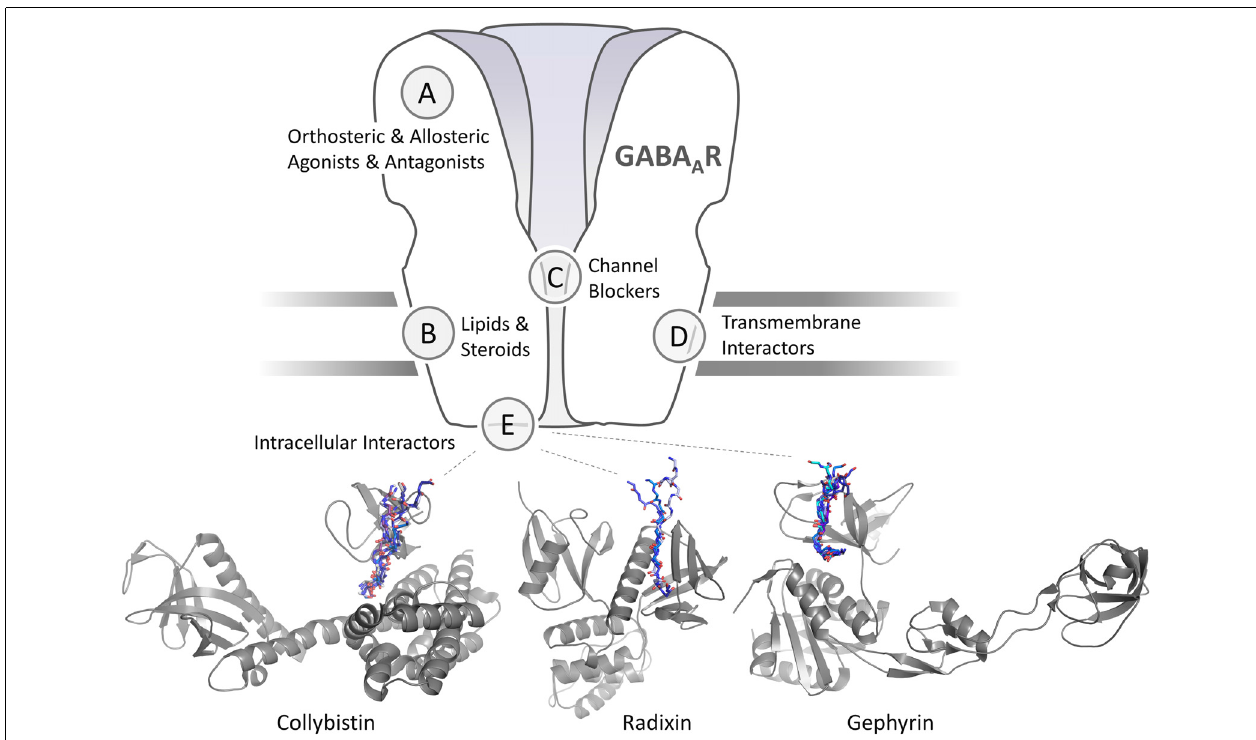
FIGURE 1 | Schematic representation of a γ -aminobutyric acid type A receptors (GABA A Rs) and sites for pharmaceutical intervention. Orthosteric and allosteric agonists and antagonist are classical activity modulators that bind directly to the extracellular domain (ECD) or, in case of lipids and neurosteroids to the transmembrane domain (TMD) of GABA A Rs. Each of the sites could occur in five subunits or at five interfaces, or only in distinct subunits and specific interfaces. Channel blockers bind within the ion pore formed by the GABA A R pentamer. Intracellular interactors such as Collybistin (CB; Hines et al., 2018) and gephyrin (Maric et al., 2014) interact with distinct intracellular regions of a subset of GABA A R subunits. Transmembrane interactors such as LHFPL4 interact with the TMDs of γ 2 subunit containing GABA A Rs (Davenport et al., 2017; Yamasaki et al., 2017). Cartoon representation of structurally characterized and predicted scaffold-GABA A R complexes. CB is shown in gray in its extended conformation (PDB-ID 4mt7) with its SH3 domain (PDB-ID 4mt6; Soykan et al., 2014) binding to a fragment of the GABA A R α 2 subunit (Hines et al., 2018). Peptide backbones of resolved SH3 domain ligands (PDB-IDs 2df6, 4hvu, 4hvv, 4hvw, 4j9f, 4ln2 and 4rtz) are superimposed to indicate the putative GABA A R α 2 binding site. The radixin FERM domain is shown in gray. Peptide backbones of resolved radixin FERM domain ligands (PDB-IDs 1j19, 2ems, 2d2q) are superimposed to indicate the putative GABA A R α 5 binding site. Cartoon representation of the gephyrin E domain in complex with short linear GABA A R (PDB-IDs 4tk1, 4tk2, 4tk3, 4tk4) and GlyR derived peptides (PDB-IDs 2fts, 4u90,